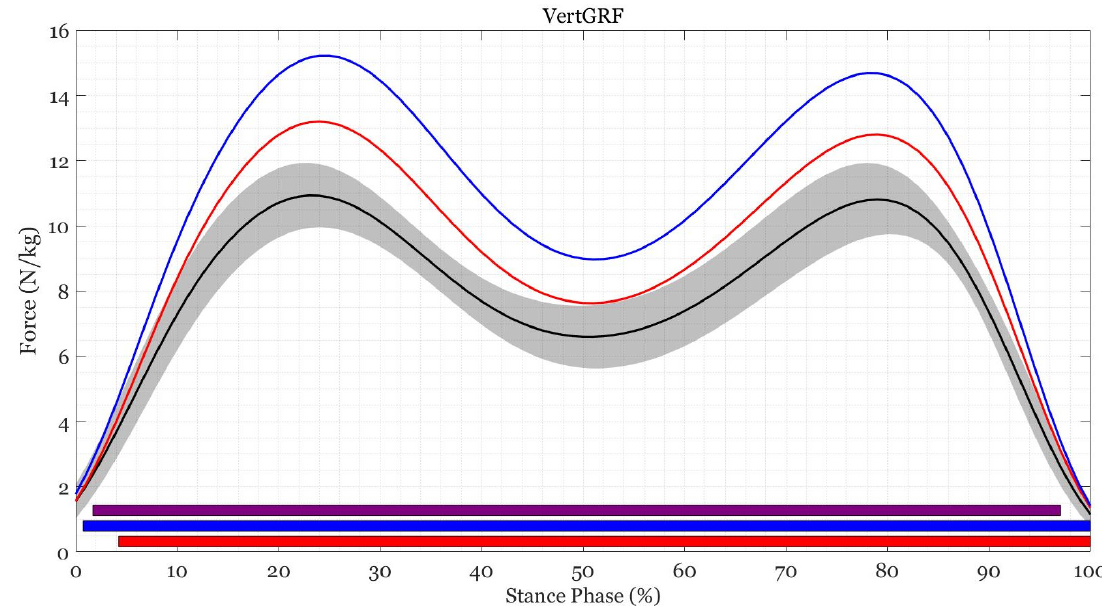
Figure 3. Mean trajectories for vertical ground reaction force during load carriage of 0% BM (black), 20% BM (red), and 40% BM (blue). The colored bars show when the SPM { t } critical threshold was exceeded between 0% BM and 20% BM (red), 0% BM and 40% BM (blue), and 20% BM and 40% BM (purple).